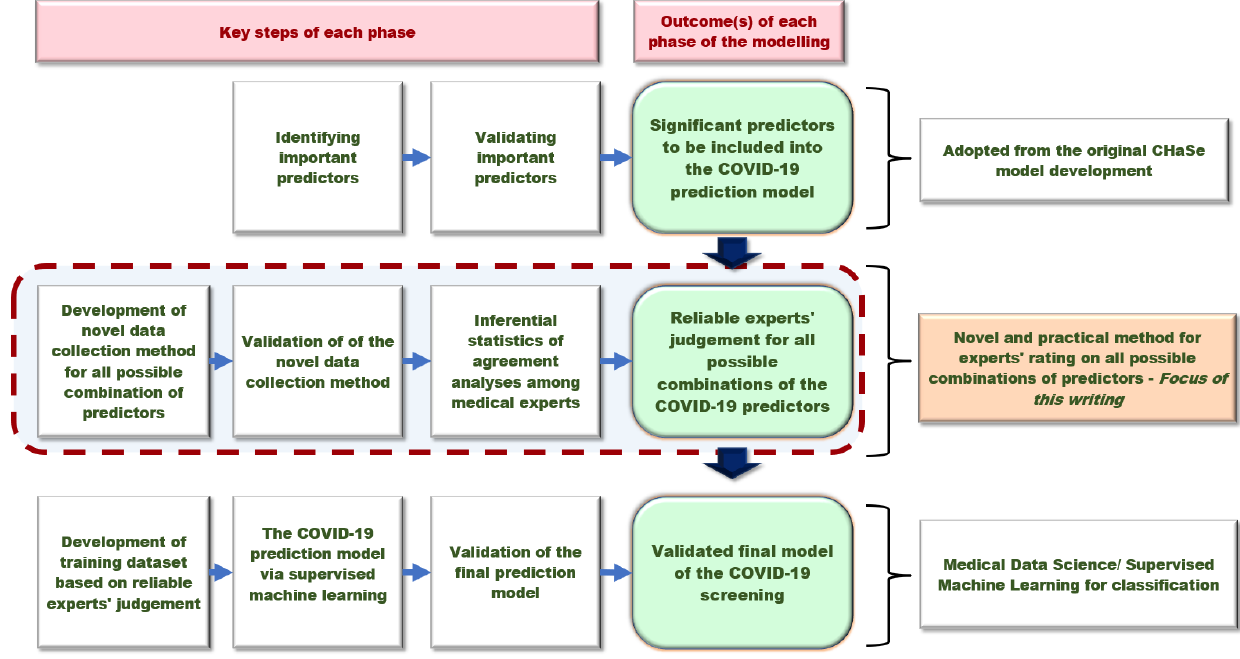
Figure 1. Conceptual framework for the overall methodology of a combinatorial-based prediction model for the COVID-19 Public Health Screening and Surveillance.